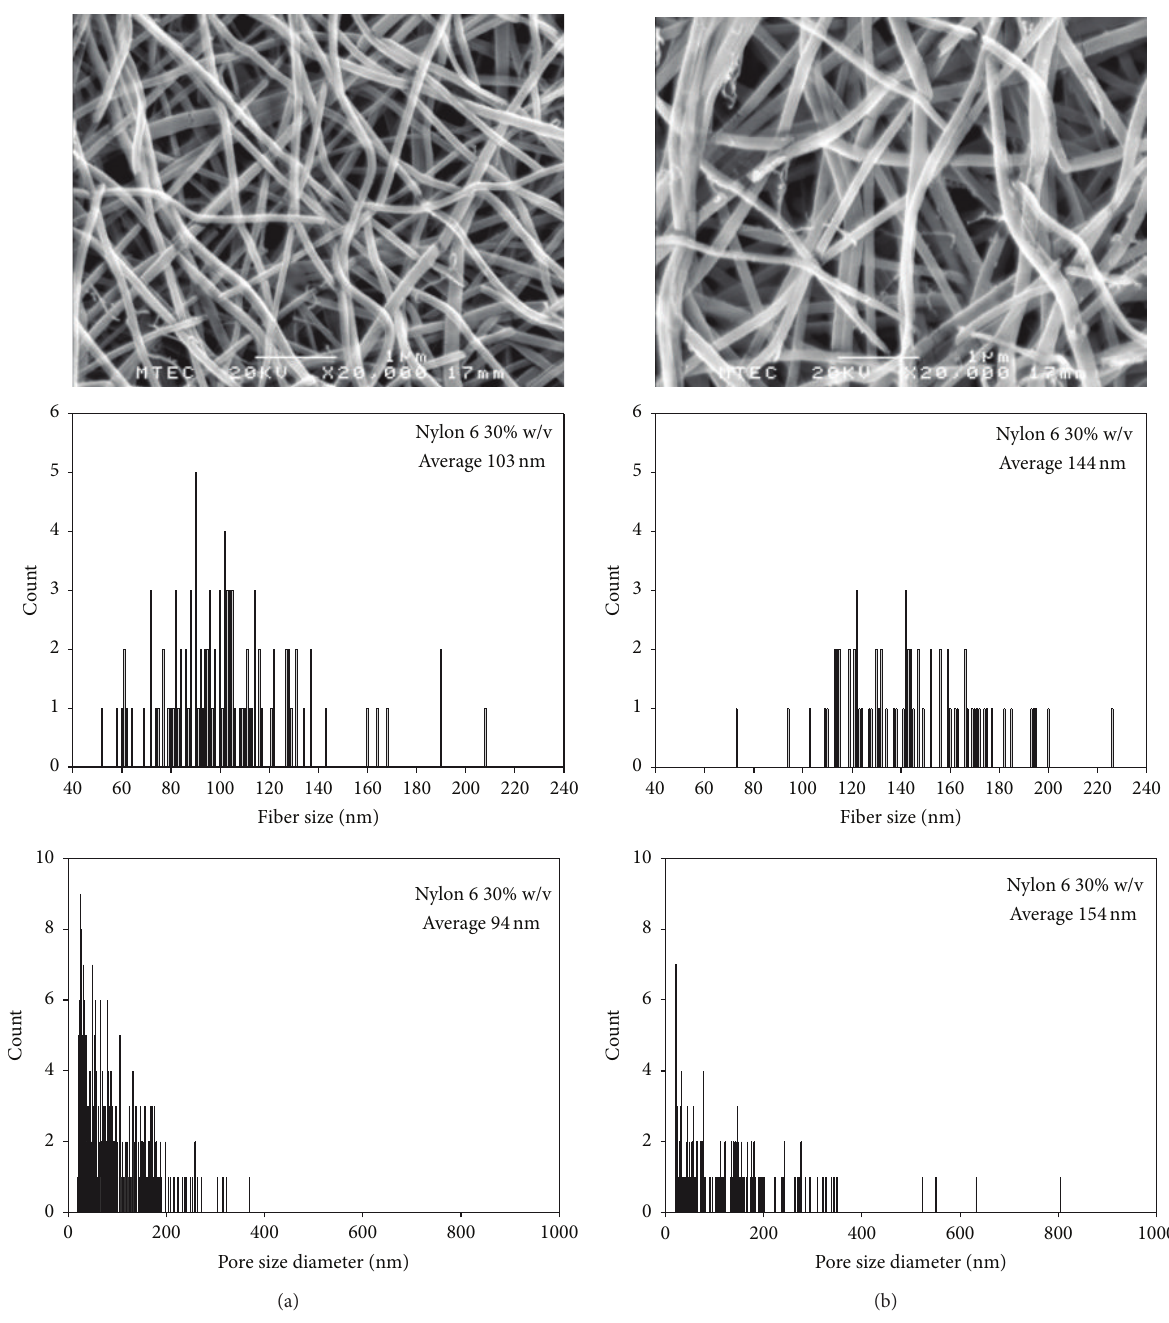
Figure 1: SEM figures of nylon-6 nanofibers electrospun from solutions of (a) 30wt% and (b) 35 wt% along with the fiber and pore size